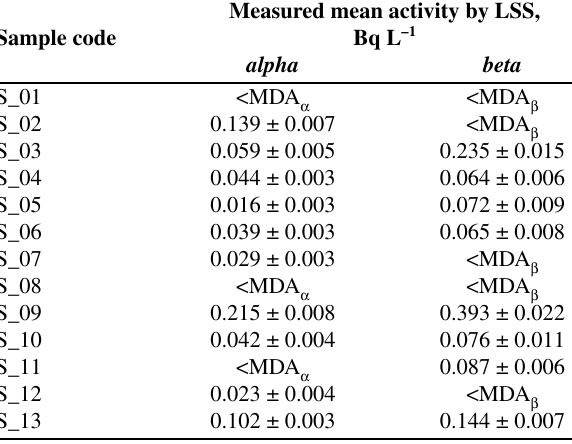
Table 6. The experimental results for gross alpha compared to refe- rence values of activity concentration in actual comparison sample Measured mean activity by